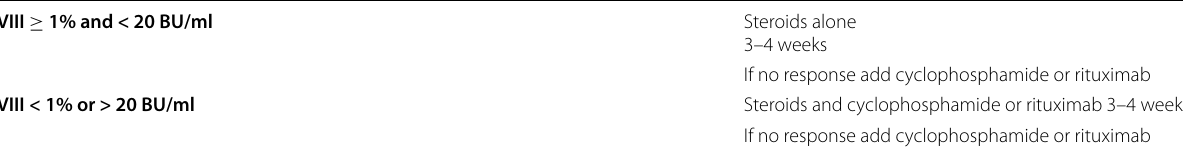
3–4 weeks If no response add cyclophosphamide or rituximab